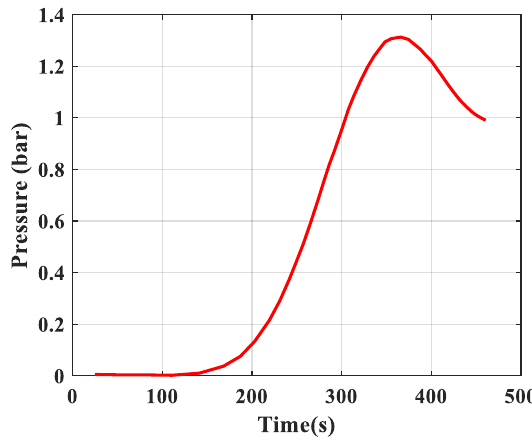
Figure 9. The result of partial pressure (O 2 ) following over time at 5.5 bar.